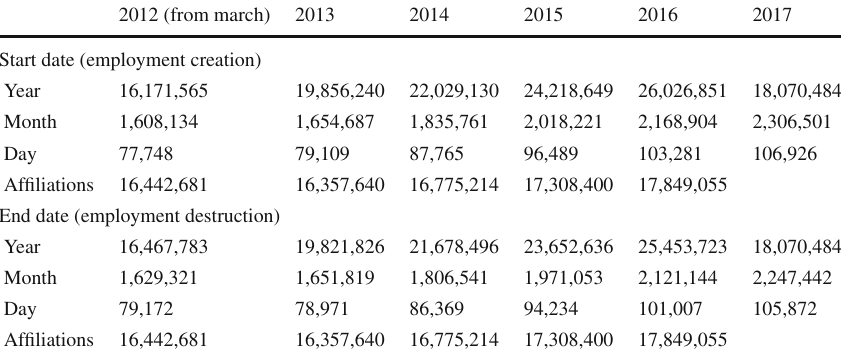
Table 6 Job creation and destruction, averages